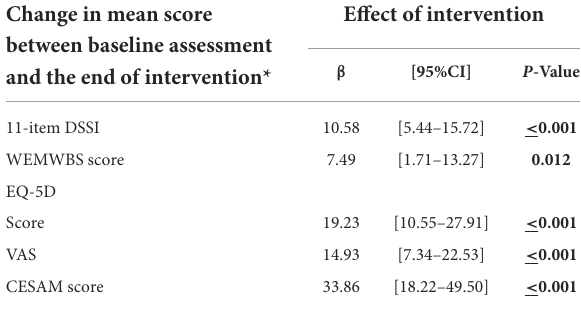
TABLE 3 Multiple linear regressions showing the association of intervention (i.e., 3-month period of virtual guided tour, independent variable) and changes in mean score between baseline assessment and end of intervention for 11-item Duke Social Support Index, Warwick-Edinburgh Wellbeing scale, EuroQol-5D and Center of Excellence Self-AdMinistered questionnaire scores adjusted for baseline participant’s characteristics ( n =